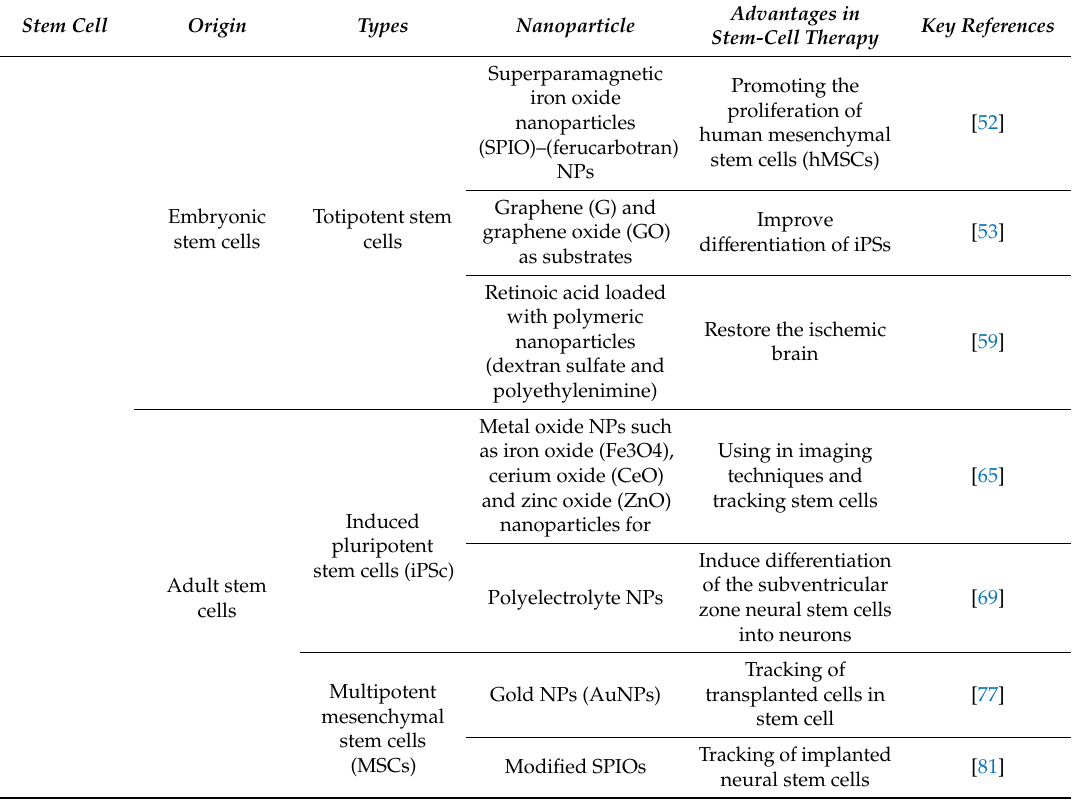
Table 1. Summary of di ff erent types of stem cells and application of nanoparticles in stem-cell therapy. Stem